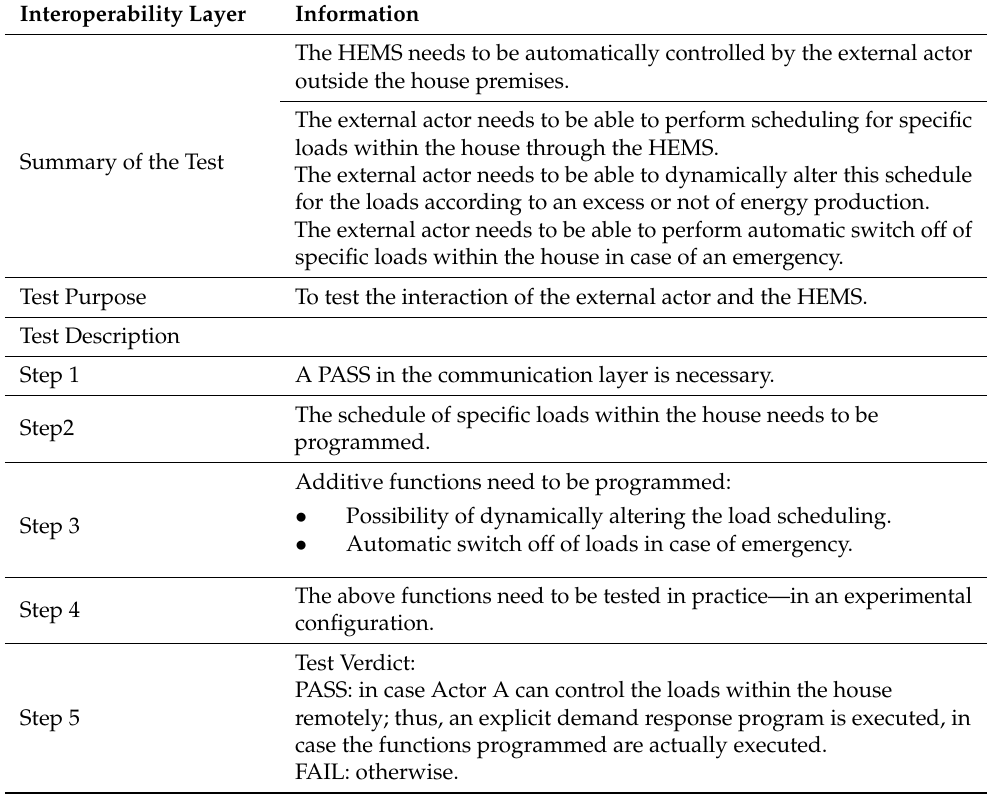
Table 3. BAIOP for the information